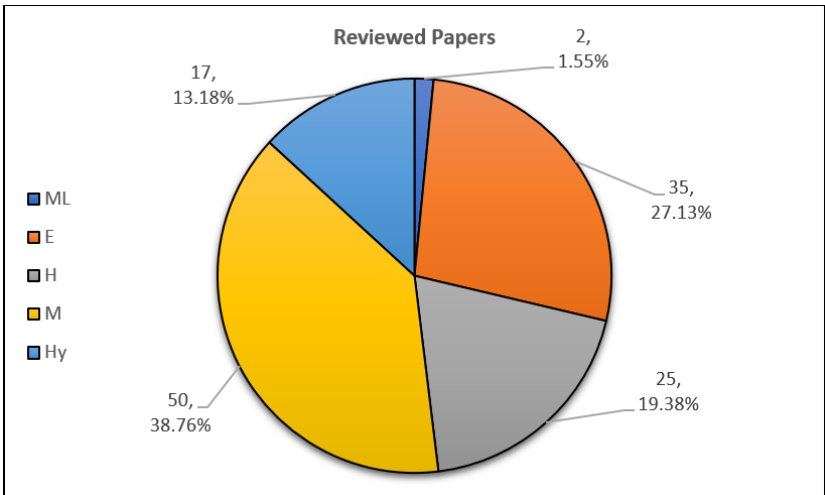
Figure 32. Breakdown of Reviewed Papers based on Solution Approach.